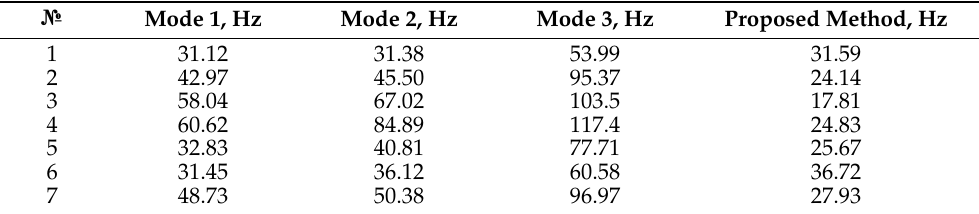
Table 3. Modes 1–3 of the printers obtained by the FEM and the lowest mode by the proposed method. № Mode 1, Hz Mode 2, Hz Mode 3, Hz Proposed Method,